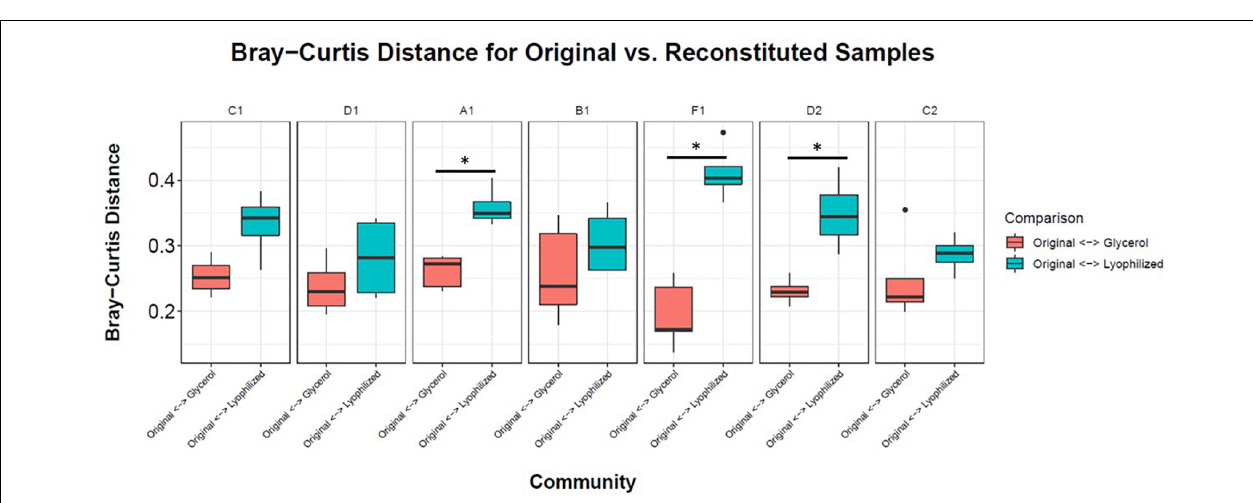
FIGURE 3 | Richness and evenness of Consortia. (A) Average richness and evenness levels for Full and Sectioned communities at the three dilution levels are shown on the x-axes. Weeks incubated are shown on the y-axes. (B) A zoom in of richness levels from weeks 5–8 for ease of viewing.